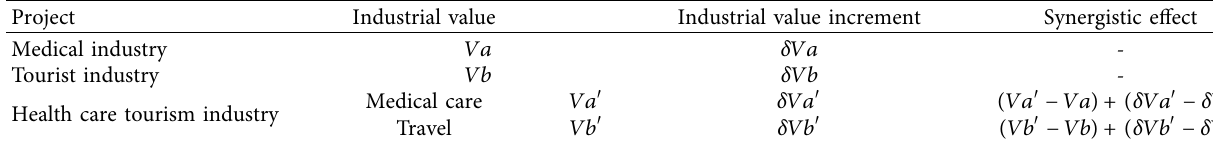
Table 1: Industrial value table.